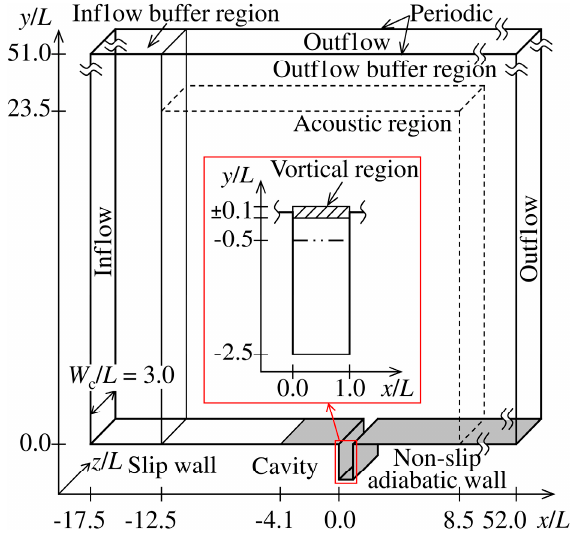
Figure 10. Computational domain and boundary conditions.